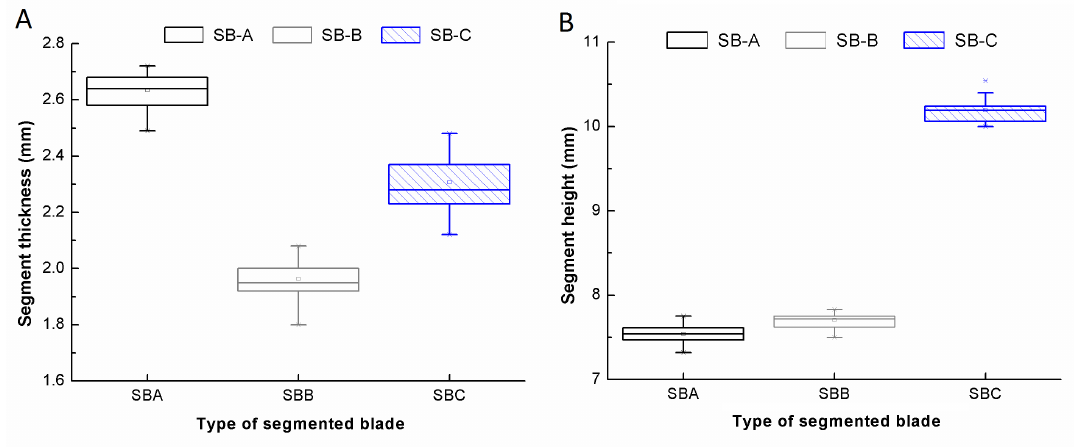
Figure 1. Boxplot of the: thickness ( A ); and height ( B ) of the cutting segments for each type of diamond